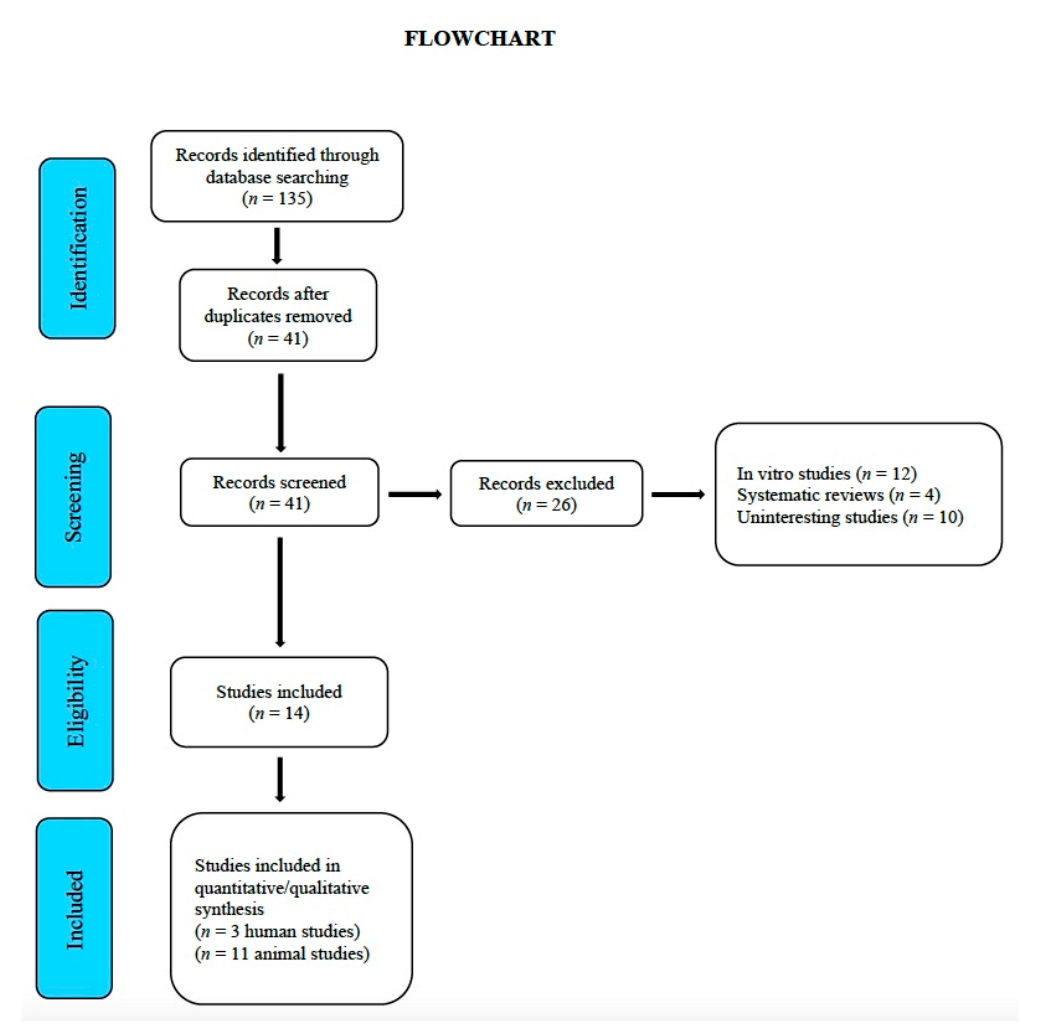
Figure 1. Figure 1. Flowchart. Table 1. Checklist of ARRIVE criteria reported by the included studies .